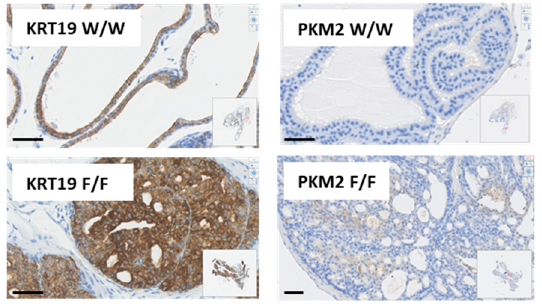
Figure 5. Representative immunohistochemistry showing the abundance of Keratin 19 (KRT19) and Pyruvate Kinase M2 (PKM2) in sections of prostate tissues from wild-type ( W / W ) and mice conditionally deleted for Pten in the prostate (F/F) at 6 weeks of age. W/W = Pten + / + ; F/F = Pten flox / flox . Scale bars: 50 μ m.